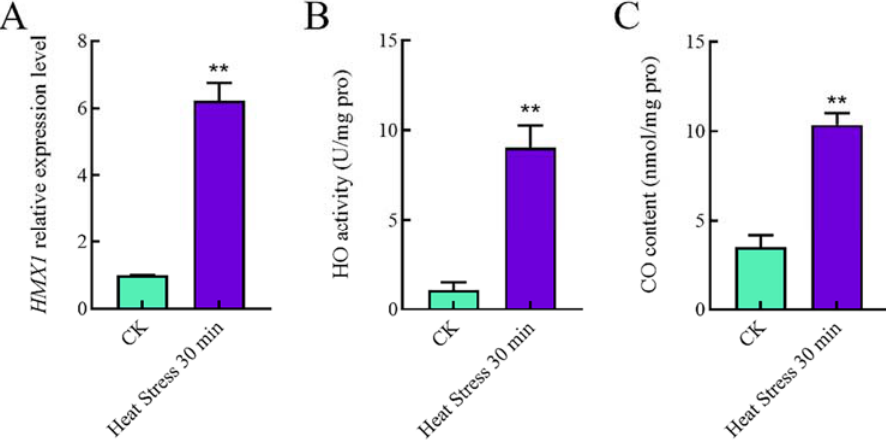
Figure 1 . Changes in HMX1 transcription level, enzyme activity, and CO content under heat shock. ( A ) The relative expression level = transcription level under heat shock treatment/transcription level under control condition (without heat shock). ( B ) HO activity was significantly increased after 30 min of heat shock. ( C ) CO content was significantly increased under heat shock for 30 min. Error bars are represented as mean ± SEM. Significance was accepted at ** p <0.01. The same as follows.